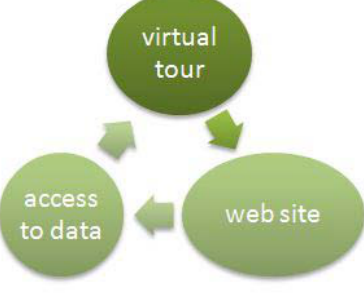
Figure 7. Virtual tour environment